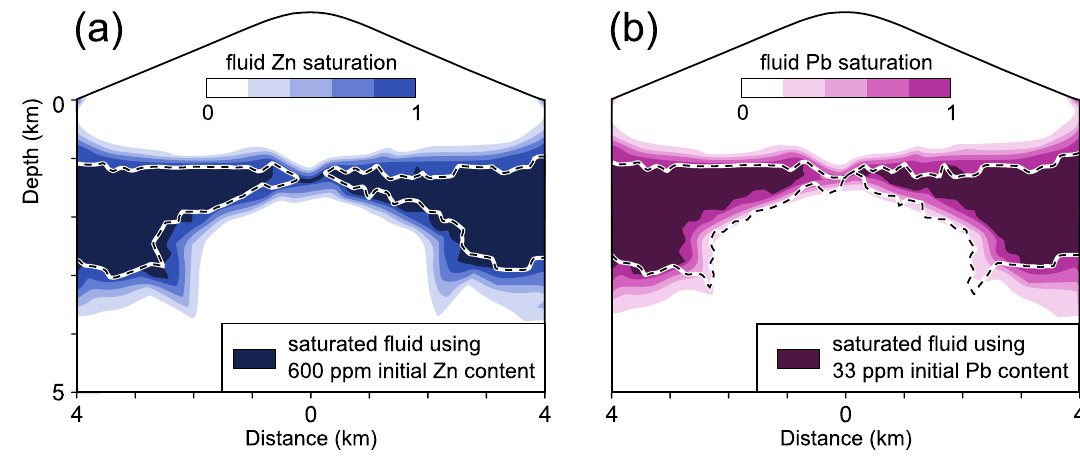
Figure 4. Variations in Zn ( a ) and Pb ( b ) saturations due to different initial metal concentrations in simulations 1 (dashed lines) and 3 (contours) after 25 kyrs of simulation